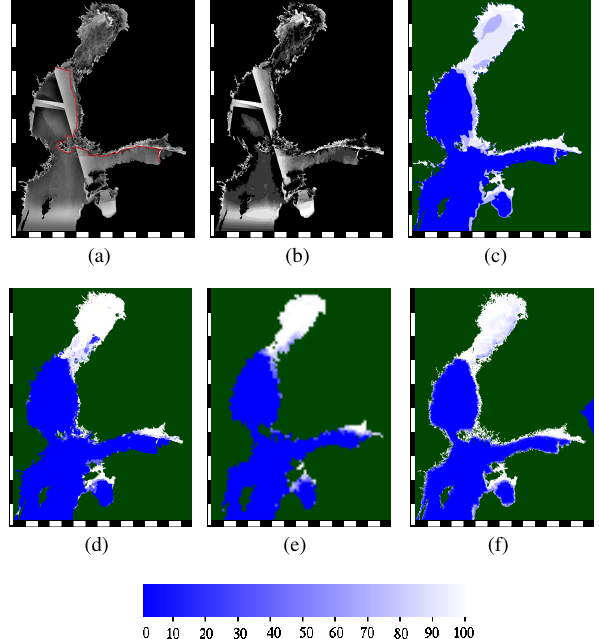
Figure 3. SAR image mosaic of 2 February 2014, © MDA (a) , the Fig. 3. SAR image mosaic of Feb. 2, 2014, ©MDA (a), the ice edge has been indicated by the red ice edge has been indicated by the red line; segmentation result (b) ; line, segmentation result (b), FMI ice chart grid ice concentration (c),ice concentration estimate using FMI ice chart grid ice concentration (c) ; ice concentration estimate our algorithm (d), AMSR-2 bootstrap algorithm ice concentration give in 10km resolution (e), ASI ice using our algorithm (d) ; AMSR-2 bootstrap algorithm ice concen- concentration (f). In the image scales the interval is one degree in both latitude and longitude, the upper tration given at a 10km resolution (e) ; ASI ice concentration (f) . In left corner is (66 o N,16 o E) and lower right corner (56 o N,31 o E). the image scales the interval is 1 ◦ in both latitude and longitude; the upper left corner is located at 66 ◦ N, 16 ◦ E, and the lower right corner is located at 56 ◦ N, 31 ◦